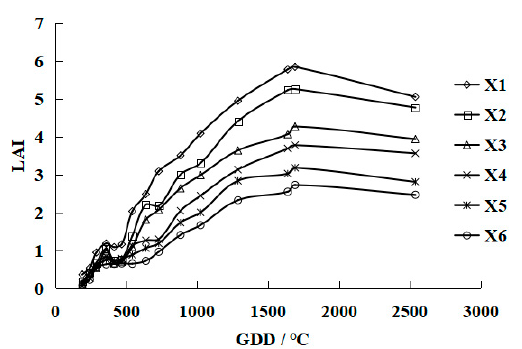
Figure 4. Relationship between leaf area index (LAI) and growing degree days (GDD) for different irrigation treatments.